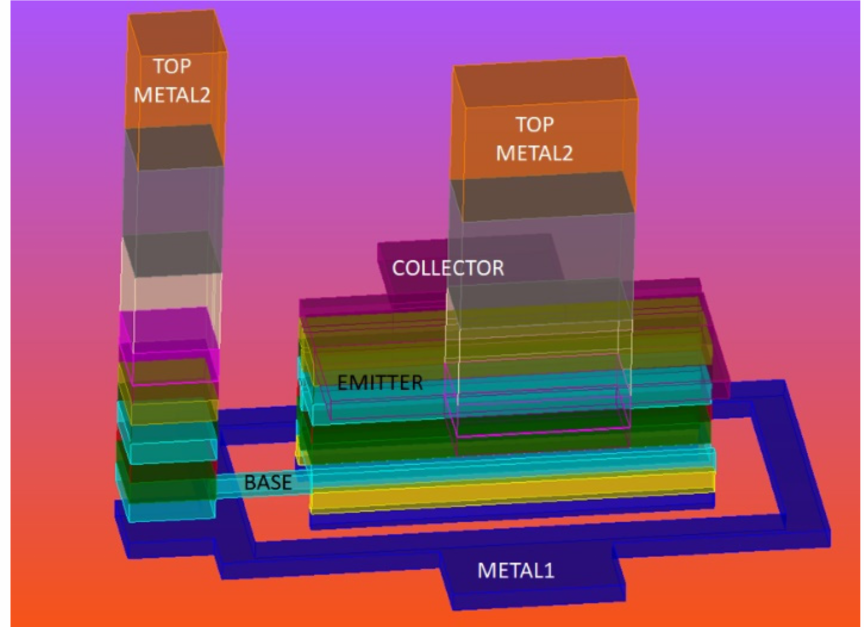
Figure 3. The 3D EM structure of HBT with metal stacked up on Base, Collector, and